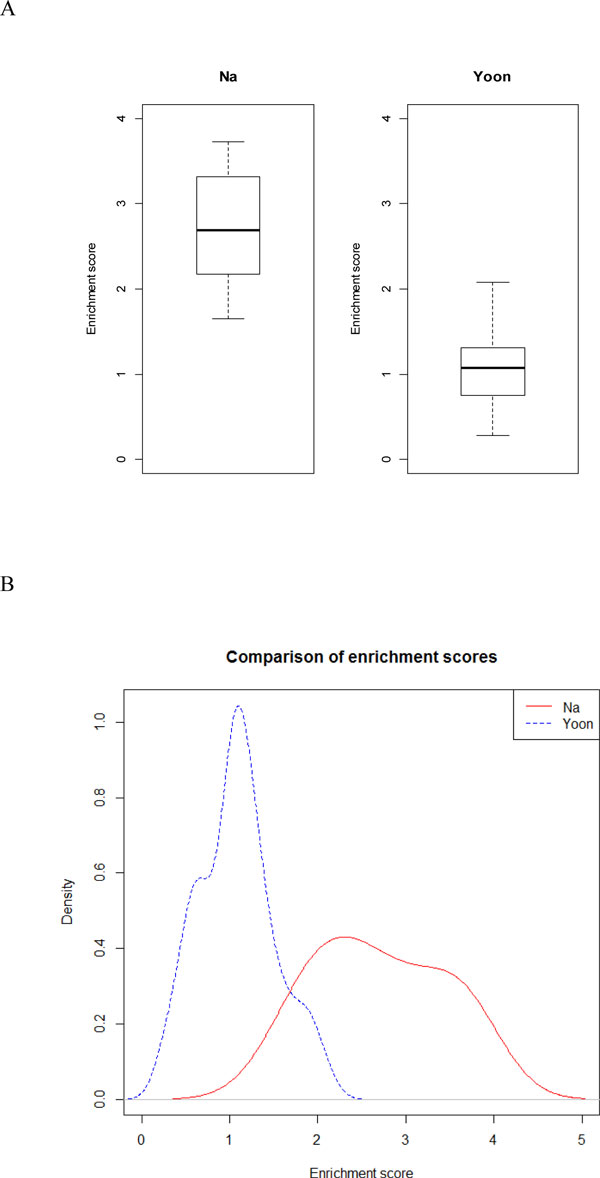
Comparison of enrichment scores of target genes between this study and previous study. We made (A) boxplot and (B) density plot in order to compare the distribution of enrichment scores of target genes between this study and previous study. These plots show that the enrichment scores of targets genes in the miRNA modules obtained from this study are statistically significantly higher than those from previous study.